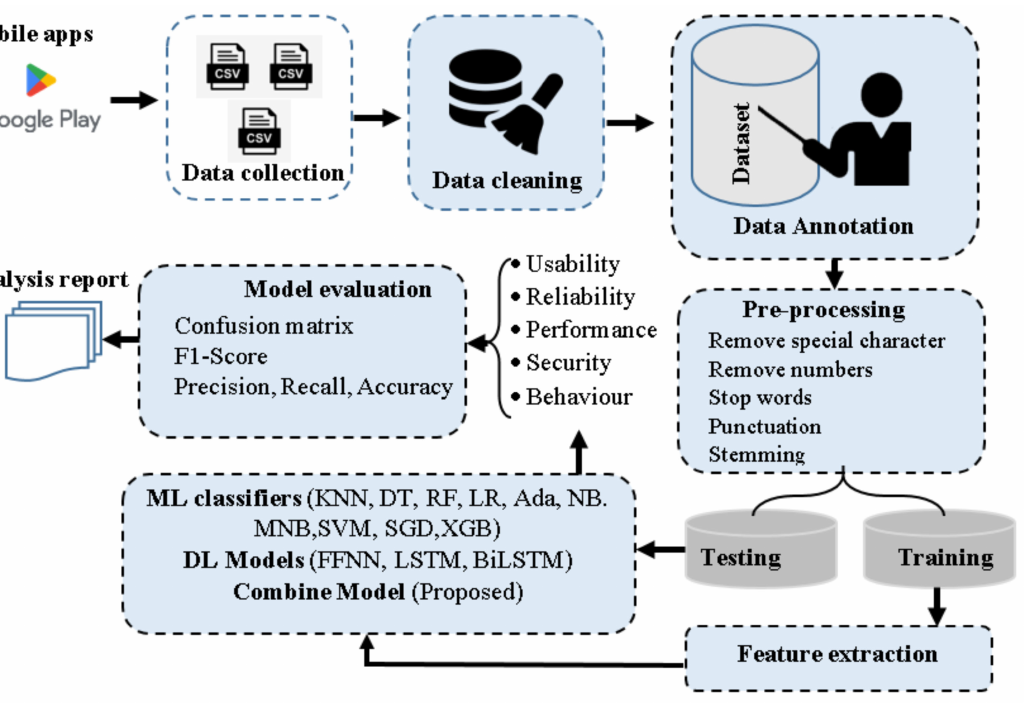
Figure 1. Research